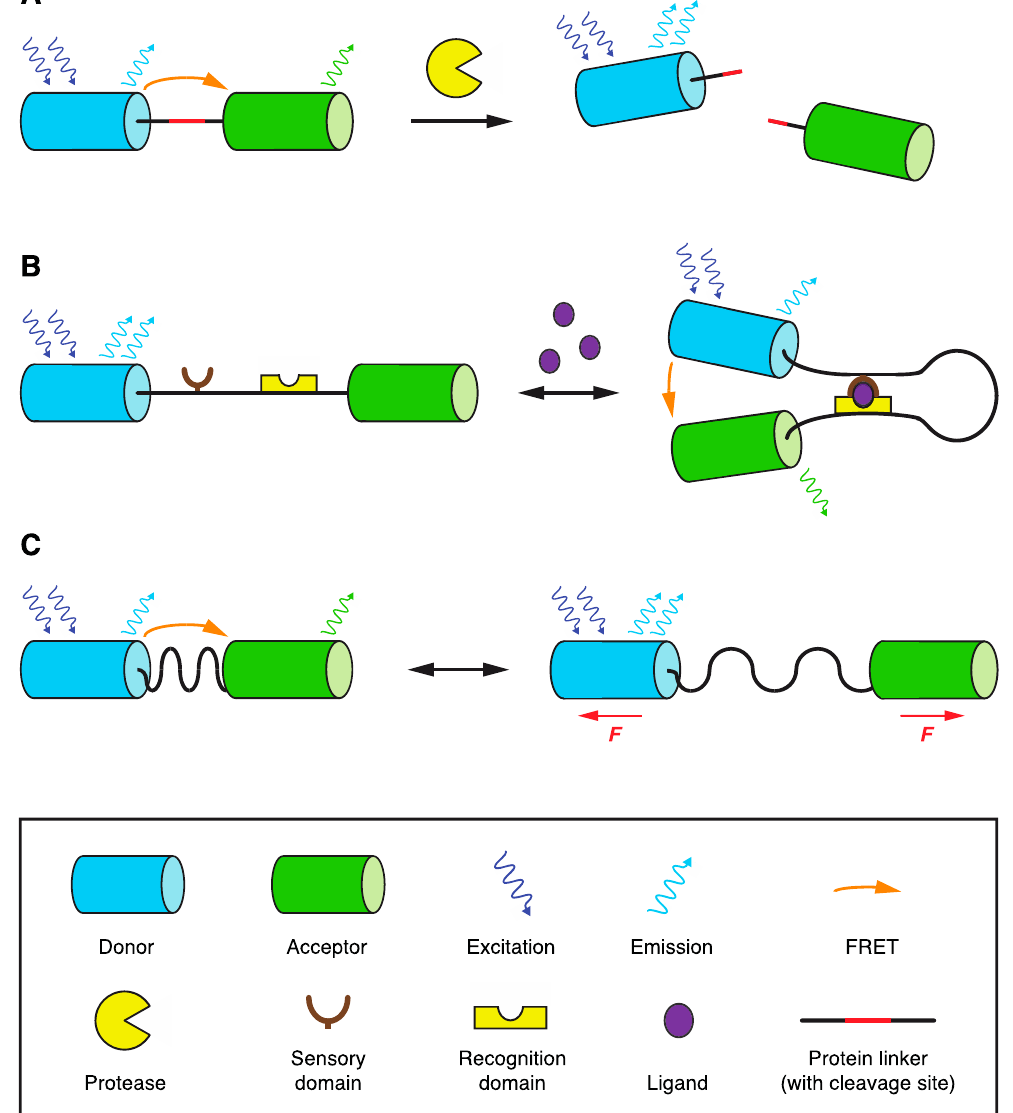
Figure 3. Common types of FP-based FRET biosensors. In these sensors, change in distance (or orientation) of appended FPs is followed by change in FRET between them. This can be used to monitor: ( A ) protease activity causing the cleavage of a particular linker between FPs; ( B ) presence of ligand or posttranslational modification on the sensory part of the sensor, which is recognized by other parts of the sensor, causing its conformational change; ( C ) molecular force/tension applied over the sensor inserted in force-bearing protein. See legend at the bottom part of the figure for further details. Adopted from [47].